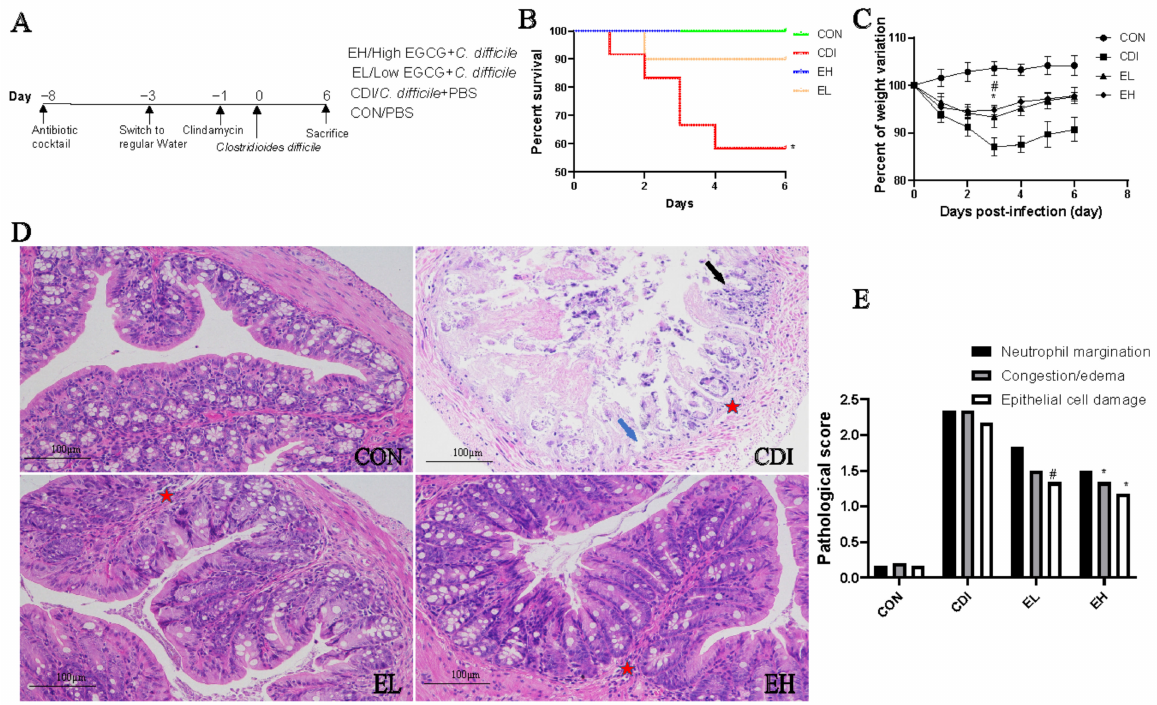
Figure 1. EGCG treatment improves C. difficile -associated colitis and increases survival. ( A ) Experi- mental protocol. CON group, negative control; CDI group, C. difficile infection; EL group, 25 mg/kg daily by gavage; EH group, 50 mg/kg daily by gavage. ( B ) Survival curves of mice in the four groups. ( C ) Body weight change curves. ( D , E ) Representative images and histological scores of colonic H&E staining. Blue arrow represents epithelial structure damage; black arrow represents crypt damage; asterisk represents edema and inflammation. * represents the CDI group vs. EH group, # represents CDI group vs. EL group. * and #, p <